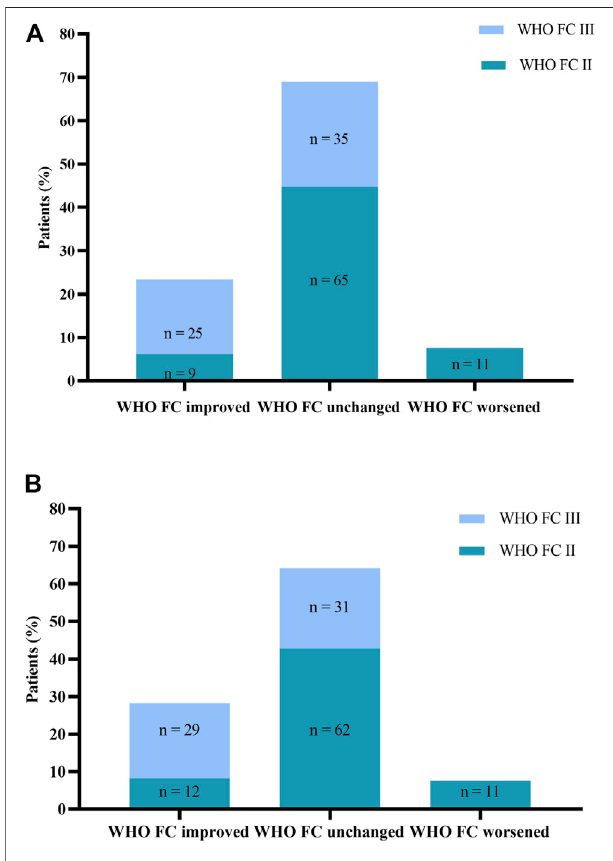
FIGURE 3 | Change in 6-min walk distance (6 MWD) from baseline to Month 6 and Month 12.